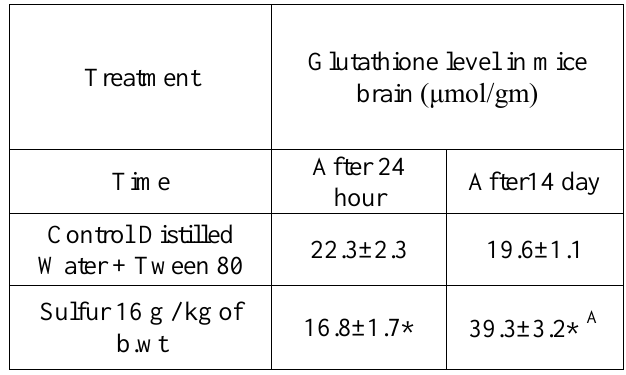
Table 7: Effect of sulfur( 16g / kg .b.wt )on brain GSH level after 24 h and14 day in mice.